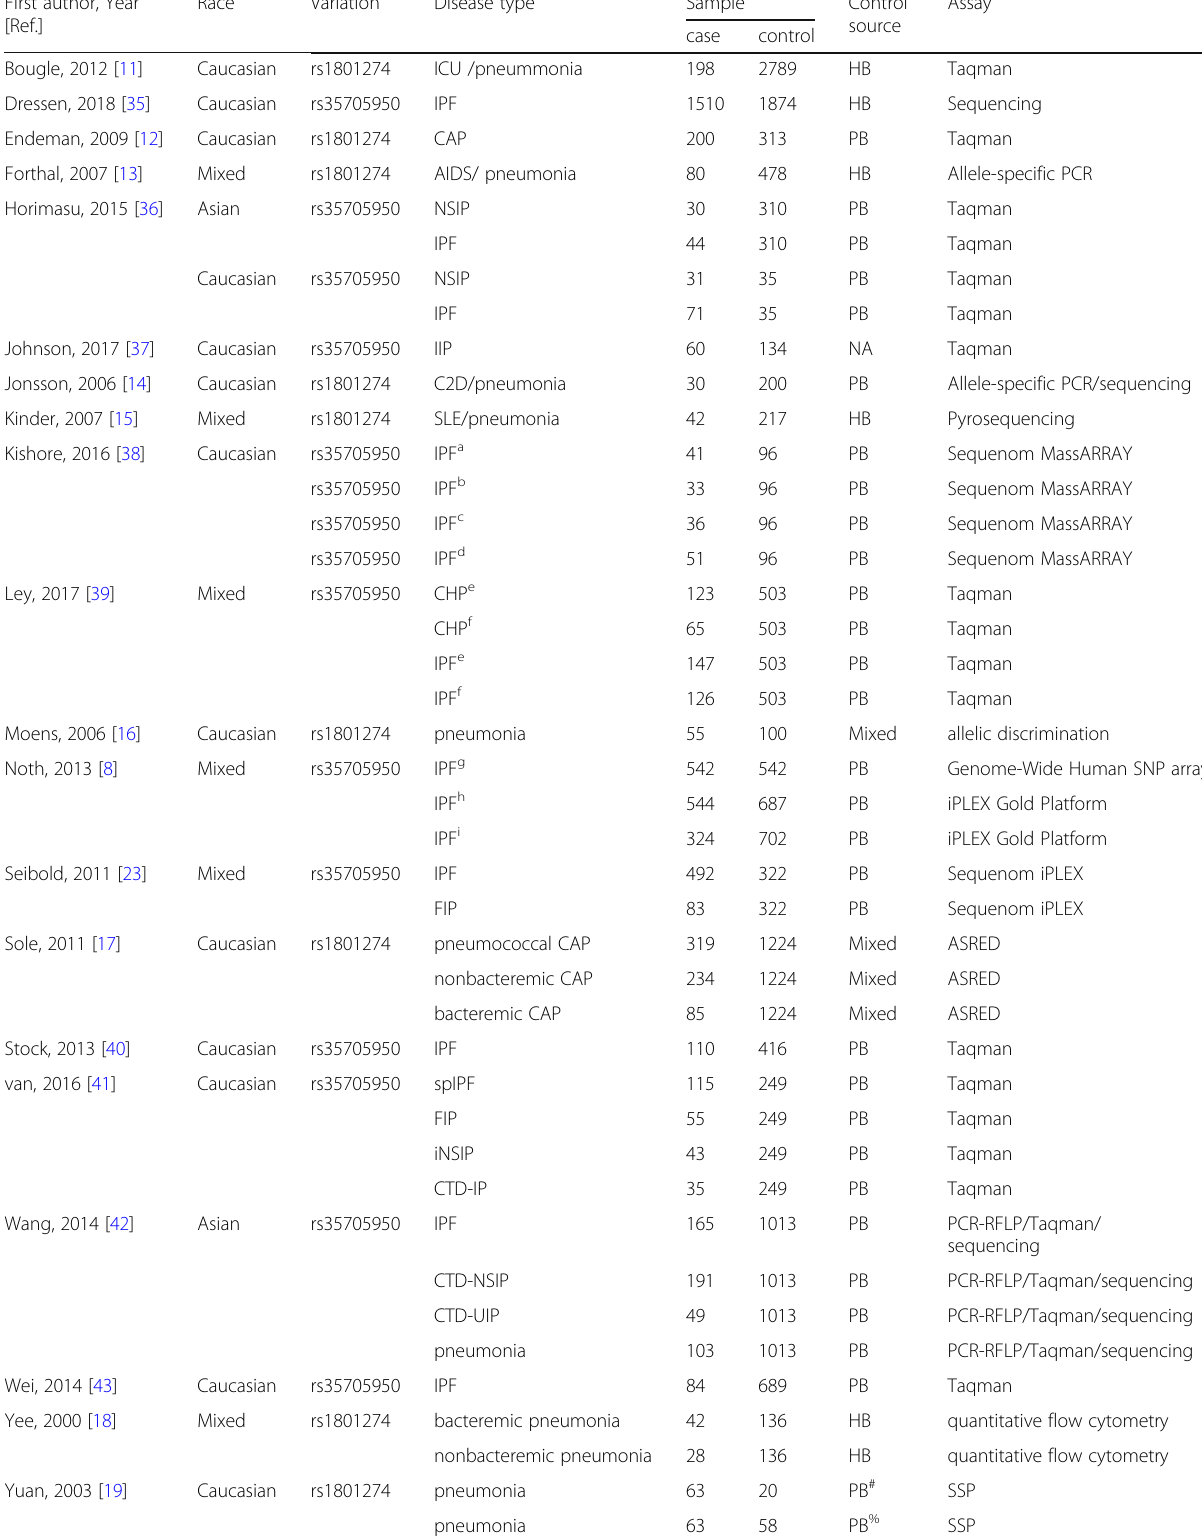
Table 1 Basic information of the studies included in the